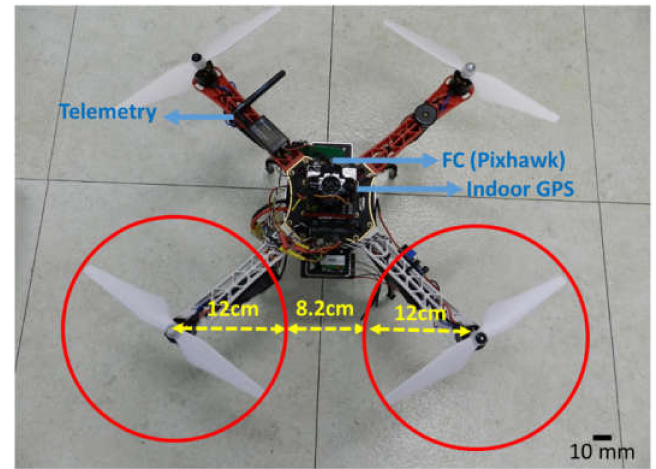
Figure 2. Top view of the customized quadrotor drone consisting of a telemetry system, precise indoor GPS system, and Pixhawk flight